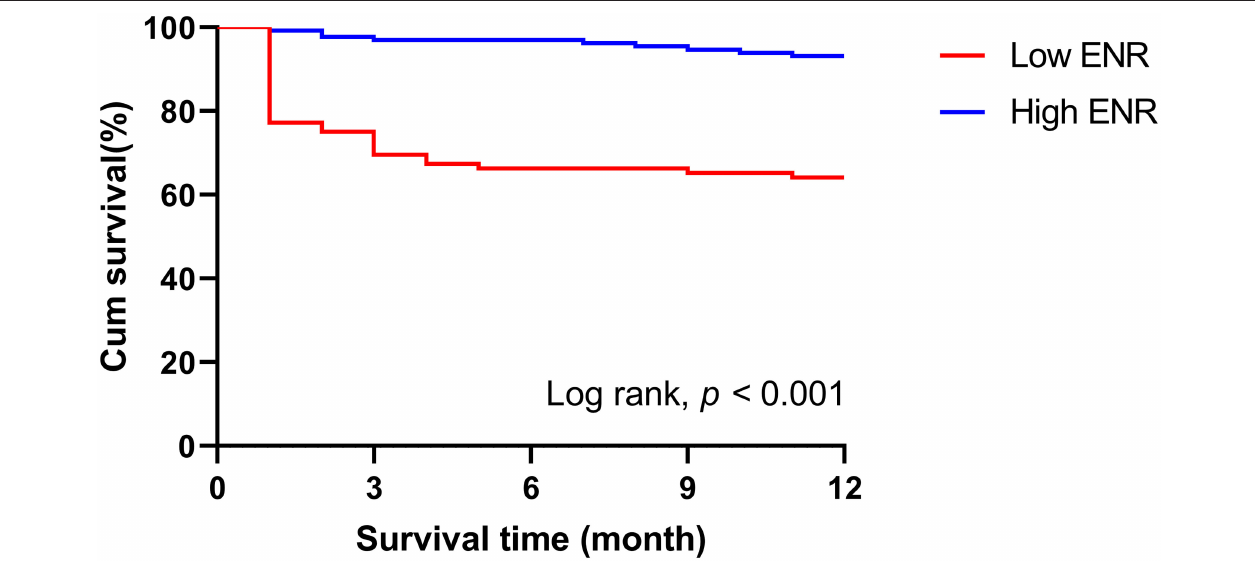
FIGURE 5 | Kaplan–Meier curves comparing the death rate of the two groups over the 1-year follow-up. ENR, eosinophil-to-neutrophil